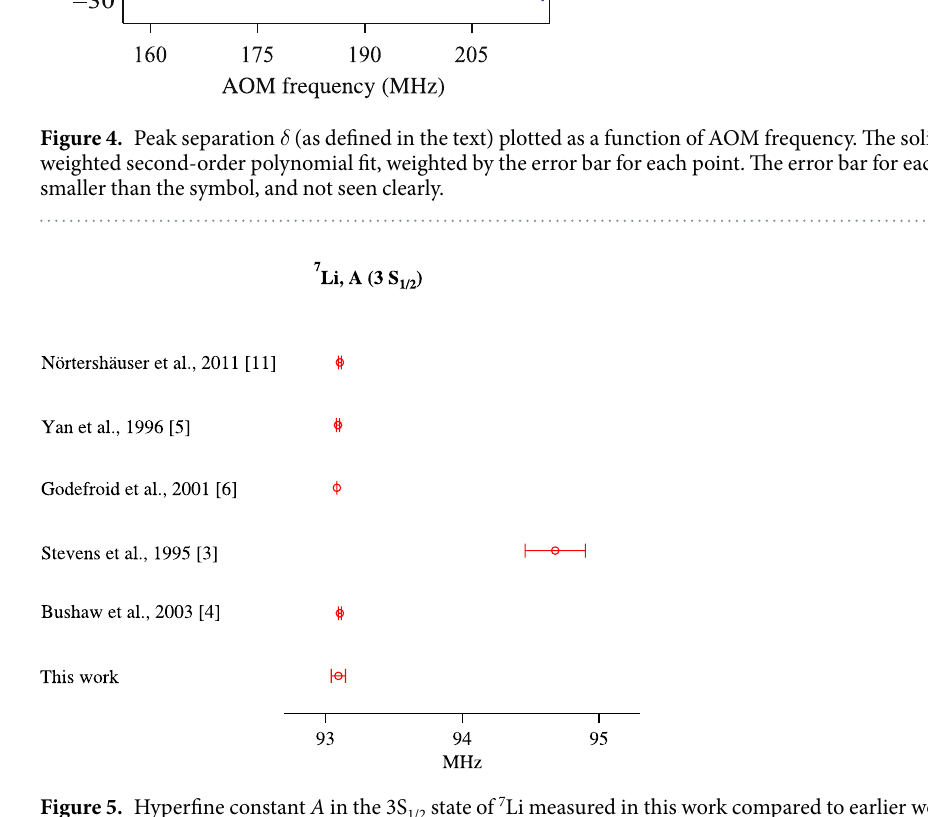
Figure 5. Hyperfine constant A in the 3S 1/2 state of 7 Li measured in this work compared to earlier